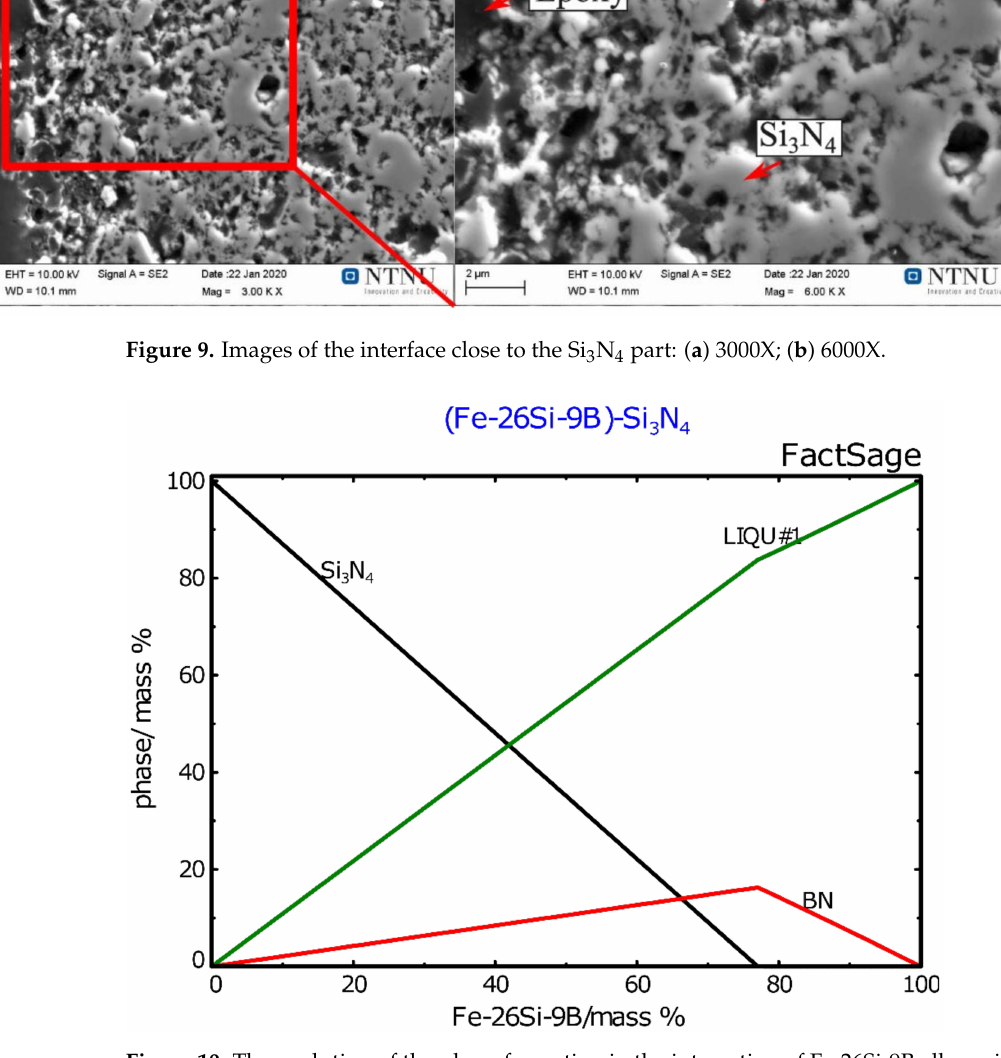
Figure 10. The evolution of the phase formation in the interaction of Fe-26Si-9B alloy with Si 3 N 4 at 1550 ◦ C. Calculated by FactSage 7.2 based on the Ftlite